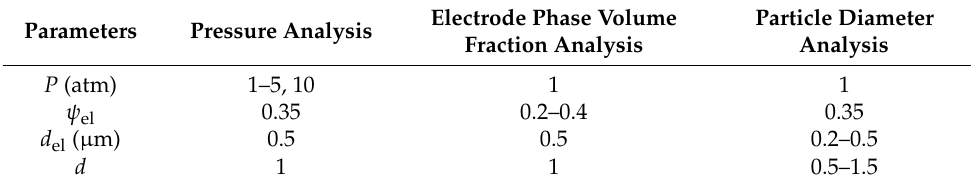
Table 6. Parameter